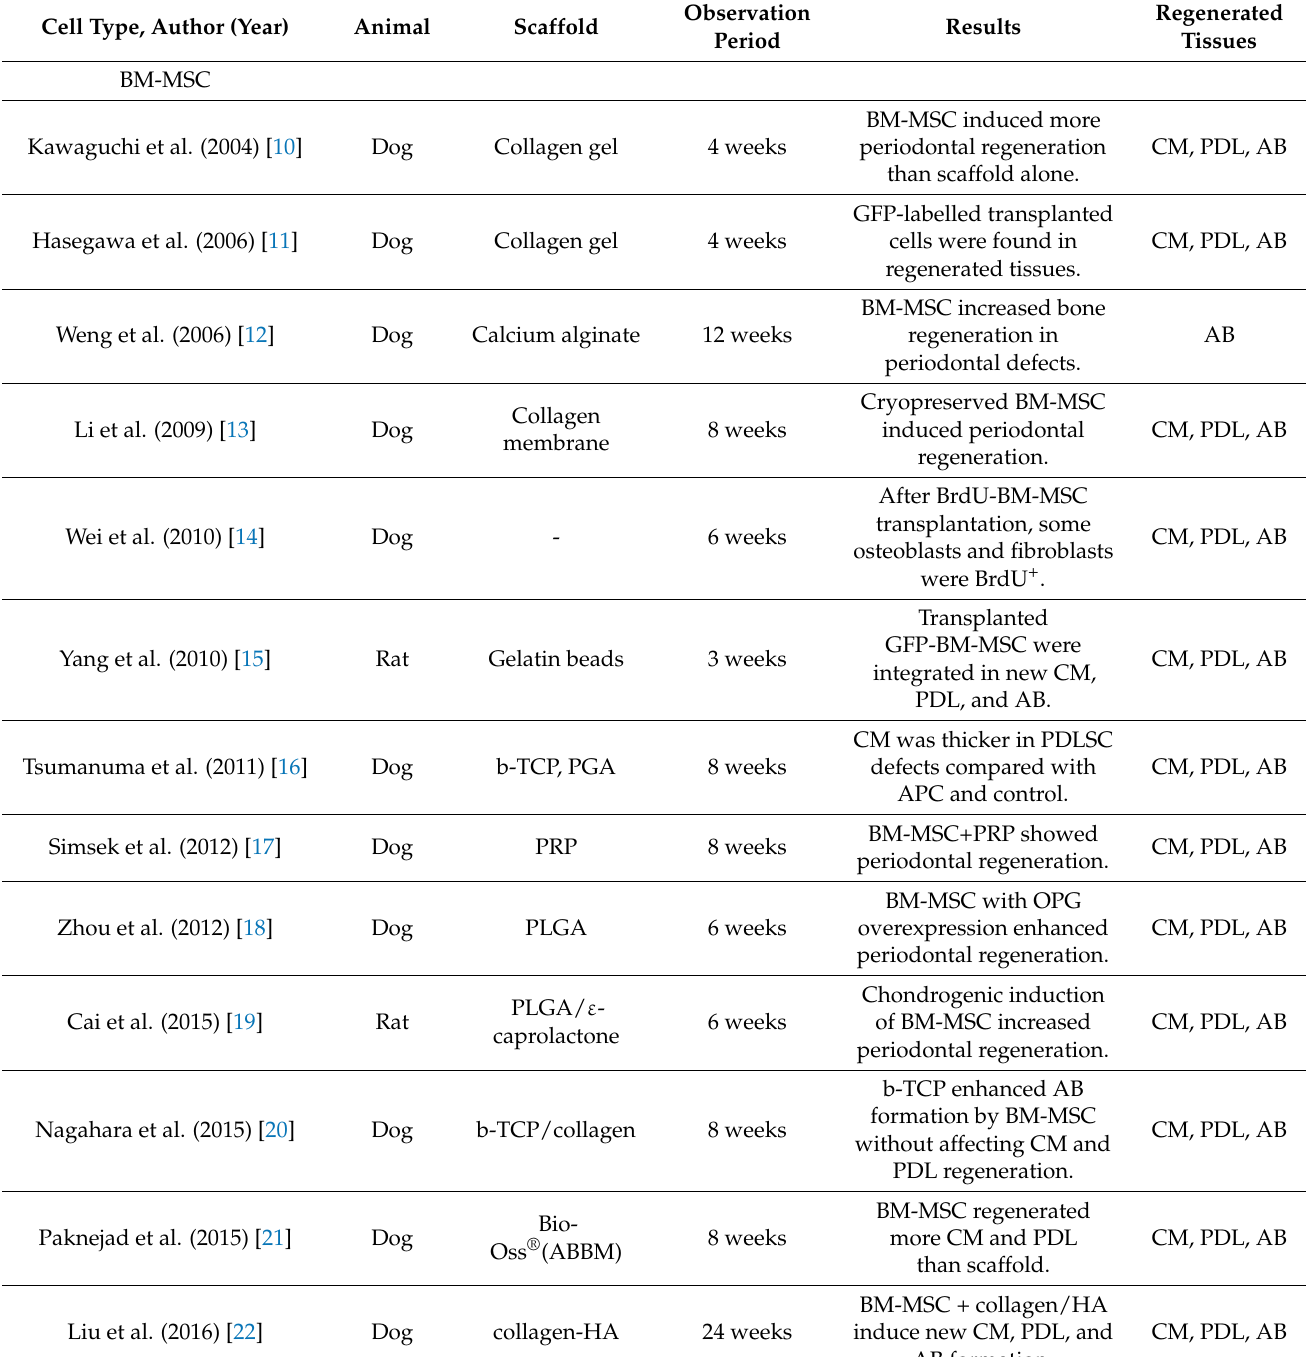
Table 1. List of preclinical studies for cell-based periodontal